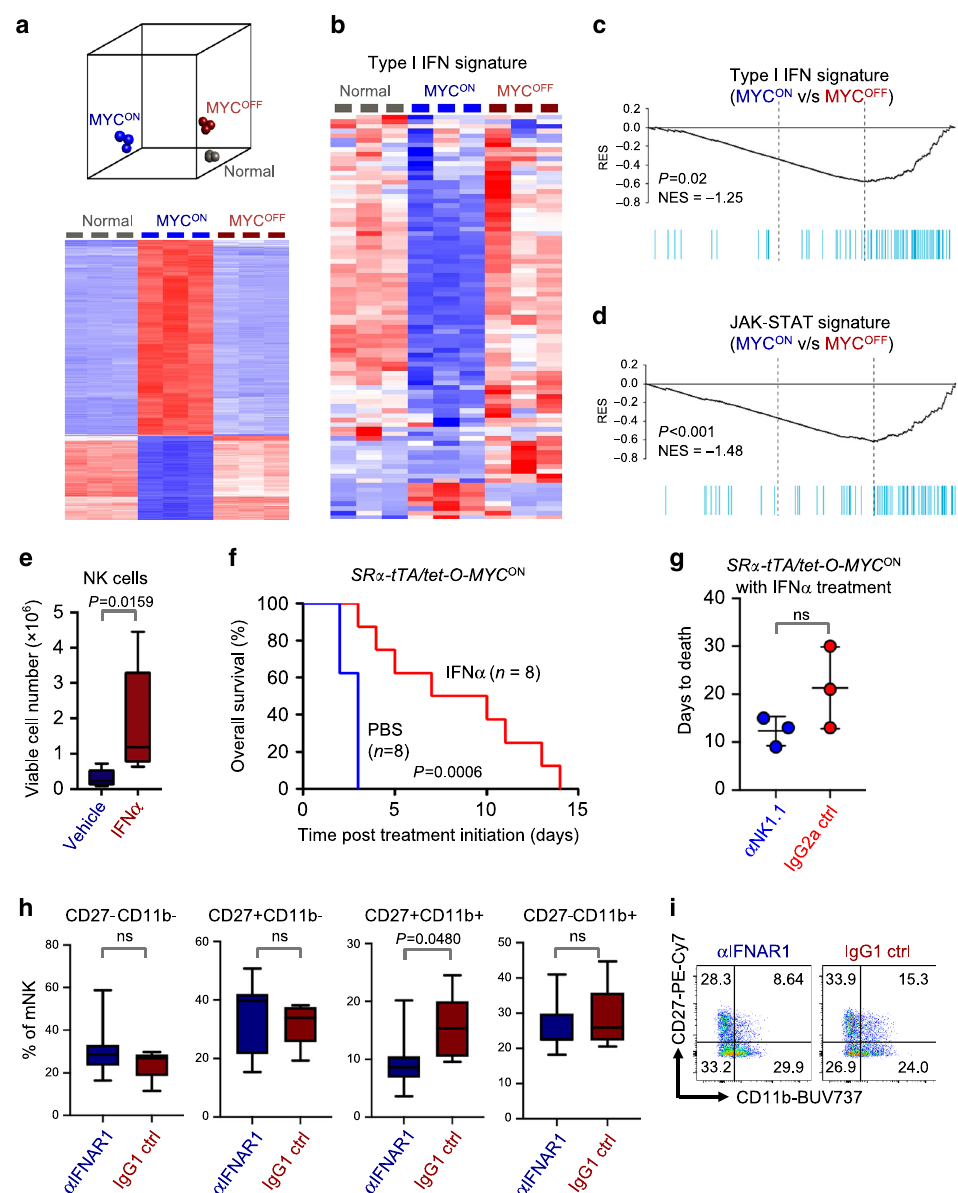
Fig. 4 Suppression of Type I IFN signaling mediates escape from NK surveillance during MYC-driven lymphomagenesis. a Principal component analysis (PCA, top) and heatmap (bottom) depicting global transcriptomic pro fi les of bulk splenic samples derived from normal ( n = 3), SR α -tTA MYC ON ( n = 3) and SR α -tTA MYC OFF ( n = 3) mice, obtained by RNA sequencing (GSE106078). b Heatmap showing suppression of Type I IFN signaling in spleens of SR α - tTA MYC ON ( n = 3) mice when compared to normal ( n = 3) and SR α -tTA MYC OFF ( n = 3) mice. c Gene set enrichment analysis (GSEA) depicting suppression of Type I IFN signature in spleens of SR α -tTA MYC ON ( n = 3) mice when compared to SR α -tTA MYC OFF ( n = 3) mice. d GSEA depicting suppression of JAK-STAT signature in spleens of SR α -tTA MYC ON ( n = 3) mice when compared to SR α -tTA MYC OFF ( n = 3) mice. e Quanti fi cation of absolute counts of CD3 − NKp46 + NK cells in SR α -tTA/tet-O-MYC mice bearing overt lymphomas ( SR α -tTA MYC ON ) treated for 3 days with either IFN α ( n = 5), or vehicle (PBS, n = 5). f Comparison of overall survival (OS) probabilities between PBS ( n = 7) and IFN α ( n = 7)-treated SR α -tTA/tet-O-MYC mice bearing overt lymphomas ( SR α -tTA MYC ON , age = 2 – 3 months). g Comparison of time to morbidity in SR α -tTA/tet-O-MYC mice bearing overt lymphomas ( SR α -tTA MYC ON ) treated with IFN α combined with either anti-NK1.1 ( n = 3) or IgG2a control ( n = 3). Data show mean ± s.d. h , i Quanti fi cation of percentages ( h ) and representative fl ow cytometry plots ( i ) of mNK cells expressing CD27 and CD11b in spleen of SR α -tTA MYC OFF (doxycycline 96 h) treated with anti-IFNAR1 ( n = 7) or IgG1 control ( n = 5). p -values have been calculated using a two-sided Mann – Whitney test. p -values: ns not signi fi cant. For all box plots, the center is at the median, minima and maxima are indicated by whiskers, and the box represents data between the 25th and 75th STAT1 promoter in P493-6 human BL and mouse MYC-driven IFN α 2 in MYC-driven lymphoma cell lines overexpressing MYC, T-lymphoma (Supplementary Fig. 24). To delineate the molecular or a MYC mutant that fails to sequester MIZ1 (MYC V394D), or mechanism behind MYC-mediated transcriptional repression of the corresponding empty vector (EV). Although MYC over- Type I IFN signaling, we compared levels of STAT1 , STAT2 and expression in P493-6 cells repressed the production of STAT1/2